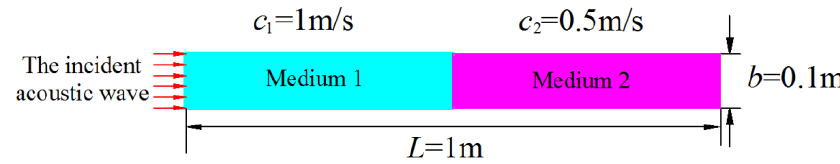
Figure 5. The transient wave propagation in a two-dimensional tube filled with different media.